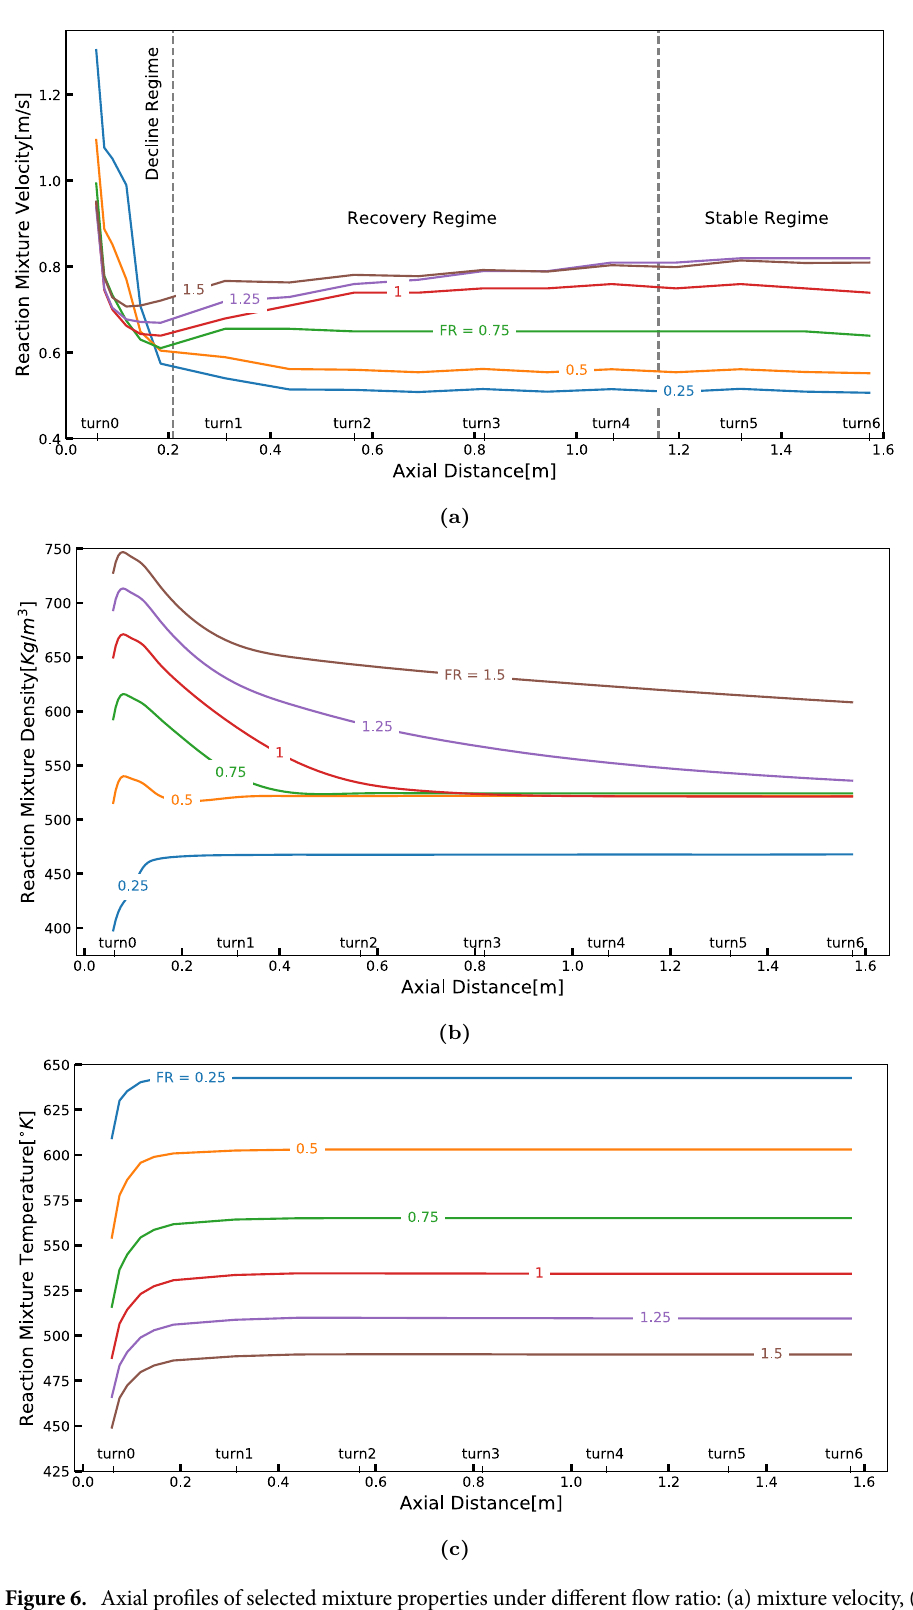
Figure 6. Axial profiles of selected mixture properties under different flow ratio: (a) mixture velocity, ( b ) mixture density, and ( c ) mixture